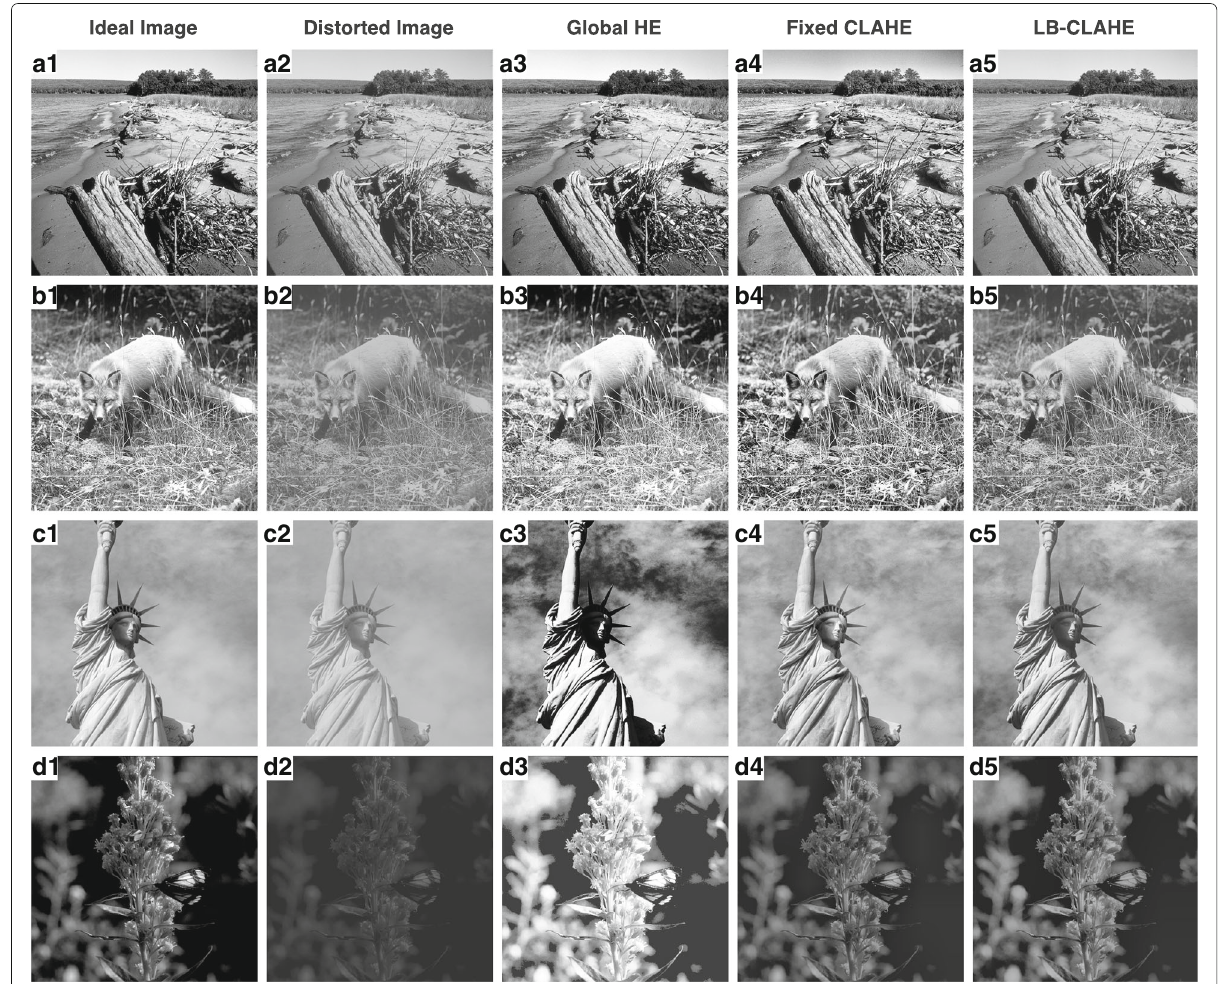
Fig. 10 LB-CLAHE’s low performance according to the IQA techniques. Best results achieved by global HE ( A ) and ( B ). Best results achieved by fixed CLAHE ( C ) and ( D ). Ideal image ( 1 ), distorted image ( 2 ), global HE ( 3 ), fixed CLAHE with CL = 0.01 and NT = [8,8] ( 4 ), proposed LB-CLAHE ( 5 )